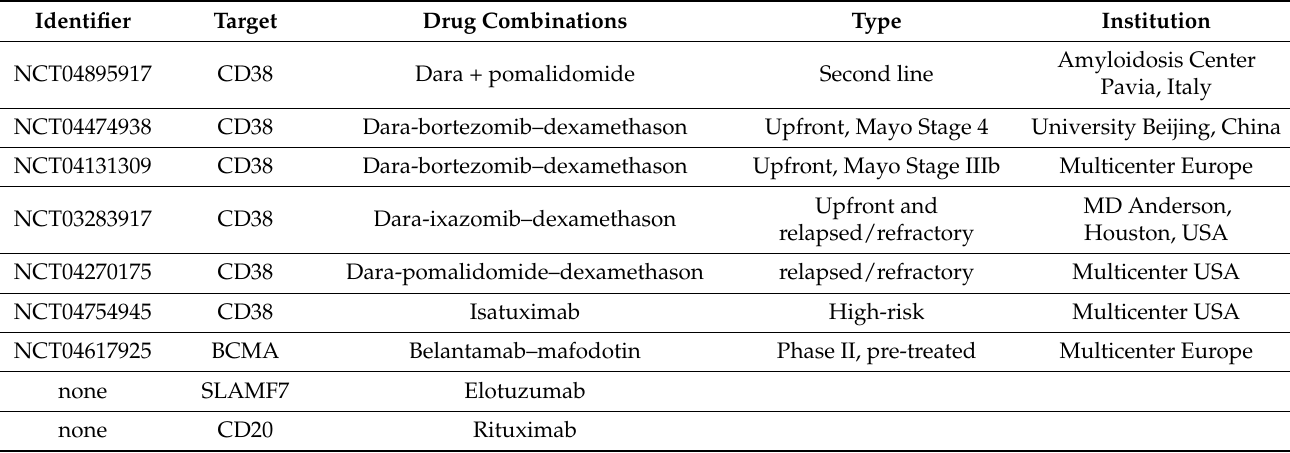
Table 2. Lists of recruiting clinical trials using monoclonal antibodies in